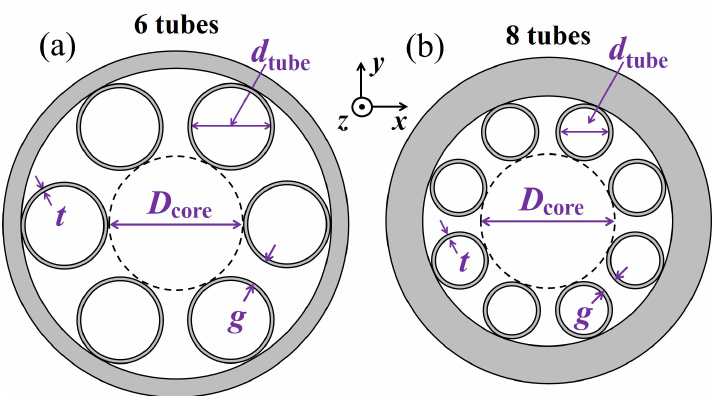
Figure 1. Schematic illustration of negative curvature fibers with ( a ) six and ( b ) eight cladding